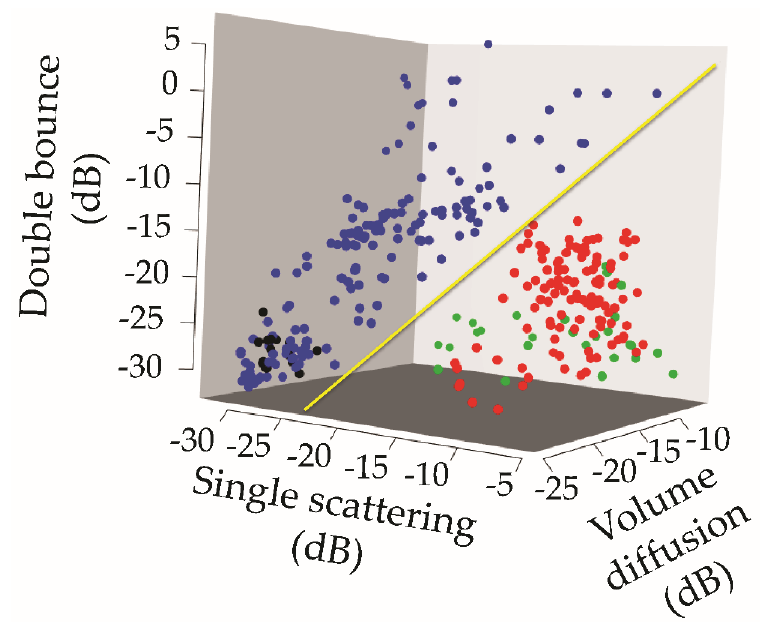
Figure 8. Backscattering coefficient (dB) of three components (single scattering, volume diffusion, and double bounce) produced by the Freeman – Durden decomposition. Each dot indicates the mean value among 25 – 30 pixels of an ROI. The blue dots (n = 150) indicate inundated paddies during the rice cropping periods. The black dots (n = 16) indicate fallow paddies just after plowing or inundated fallow periods. The red dots (n = 120) indicate noninundated paddies during rice cropping periods. The green dots (n = 27) indicate dry soils during the fallow seasons. The yellow line indicates the hyperplane of the support-vector machine between the inundated and noninundated paddies (0.281 × single scattering (dB) + 0.205 × volume diffusion (dB) − 0.233 × double bounce (dB) + 4.03).